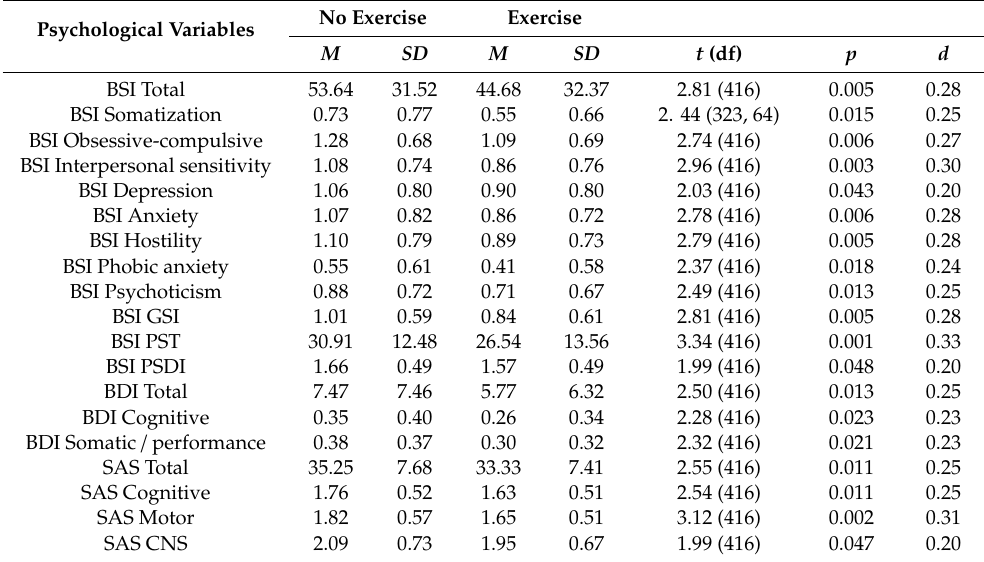
Table 9. Significant means di ff erences of exercise.